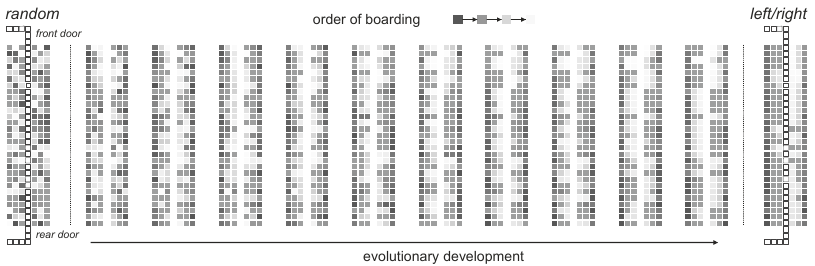
Figure 15. Evolution of boarding sequence from random sequence to a left/right sequence.